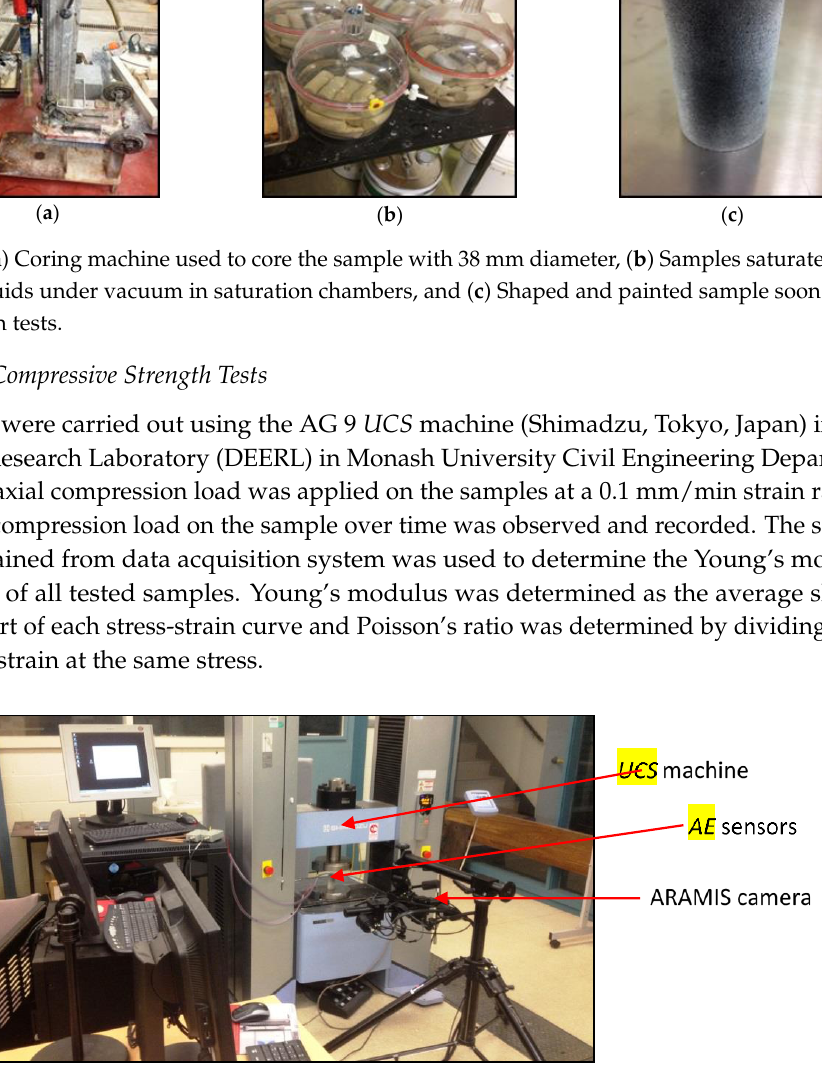
Figure 2. Experimental setup used for the mechanical testing, indicating the UCS machine, Acoustic emission system and ARAMIS